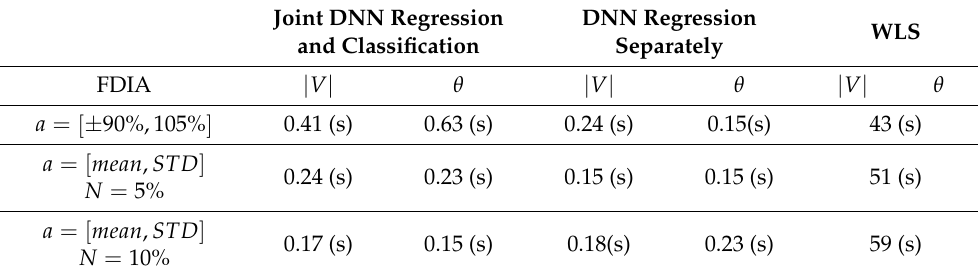
Table 8. Execution time for the proposed method, regression-only method, and WLS method. Joint DNN Regression DNN and Classification